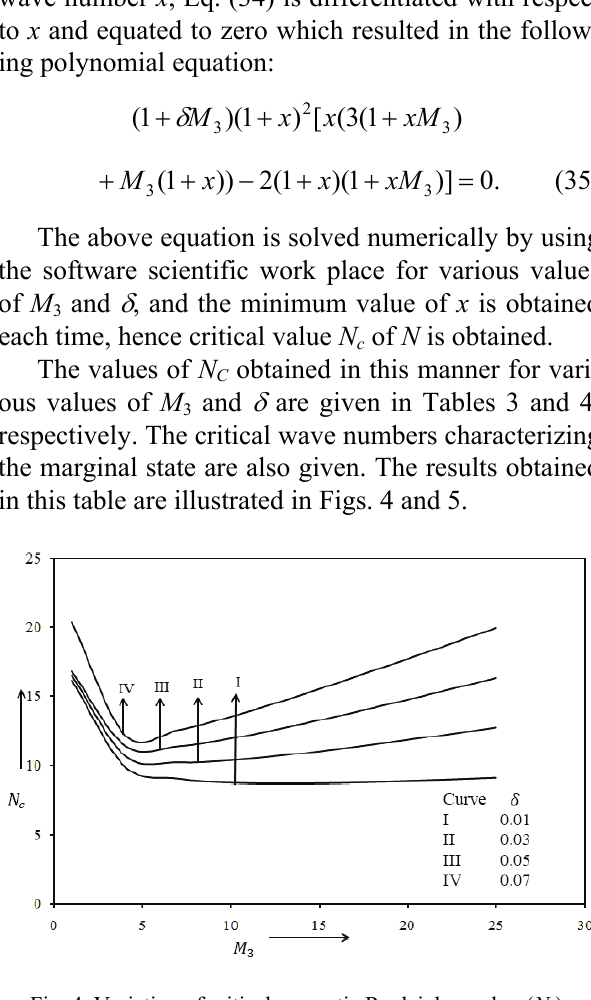
versus M for c 3